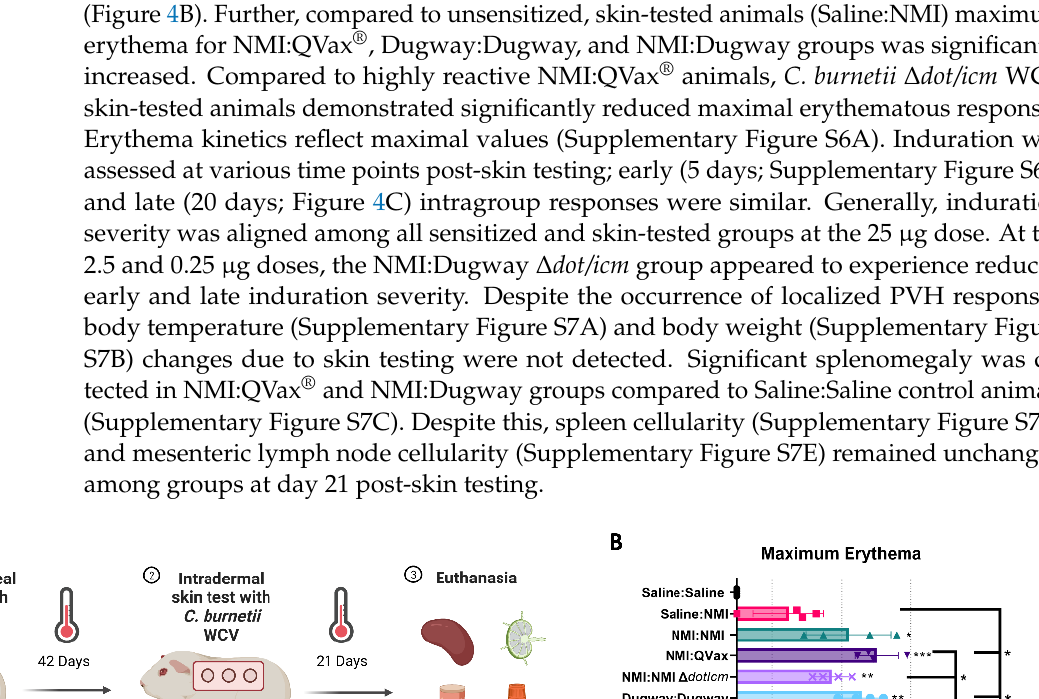
(Figure 4B). Further, compared to unsensitized, skin-tested animals (Saline:NMI) maximum erythema for NMI:QVax ® , Dugway:Dugway, and NMI:Dugway groups was significantly increased. Compared to highly reactive NMI:QVax ® animals, C. burnetii ∆ dot/icm WCV skin-tested animals demonstrated significantly reduced maximal erythematous responses. Erythema kinetics reflect maximal values (Supplementary Figure S6A). Induration was